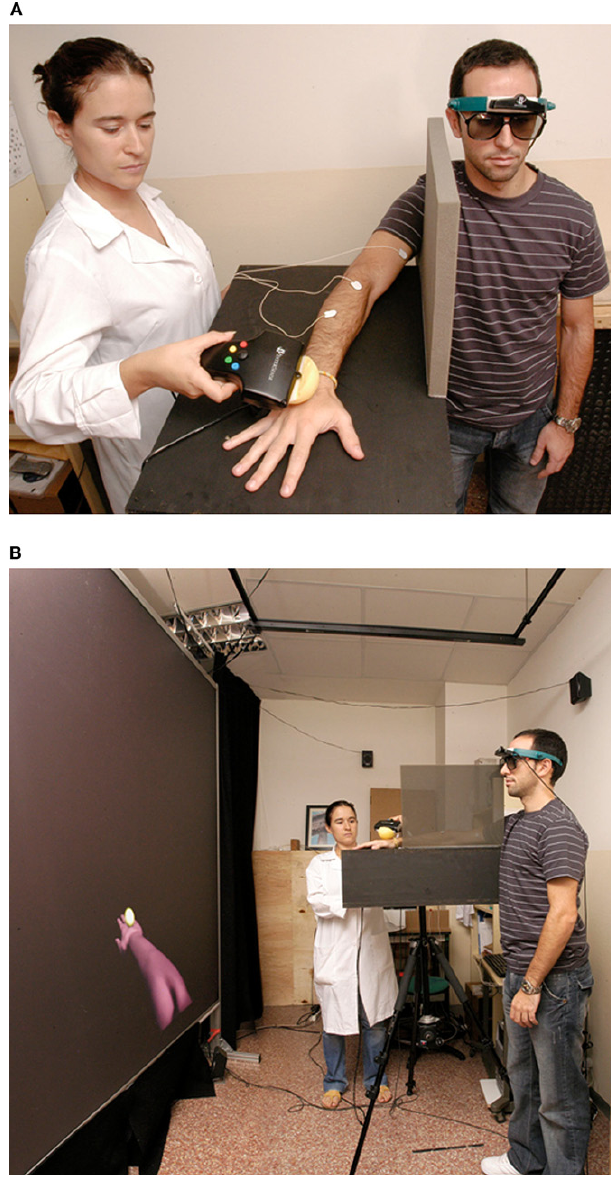
Figure 1 | The experimental setup. (A) The participant wears passive stereo glasses and a head-tracker, and the virtual image is determined as a function of his head direction. The experimenter taps and strokes the participant’s real hand with a 6-degree freedom Wand, whose position is tracked and used to determine the position of the virtual sphere. (B) The participant is standing in front of a 2 m × 2.7 m rear projection screen. The arm in the screen is seen from the participant’s point of view as projecting out of his right shoulder, while his own arm is out of view and resting on a support. In the projection the participant also sees a sphere striking in synchrony and in the same place on the virtual hand as the touch stimuli delivered to his own